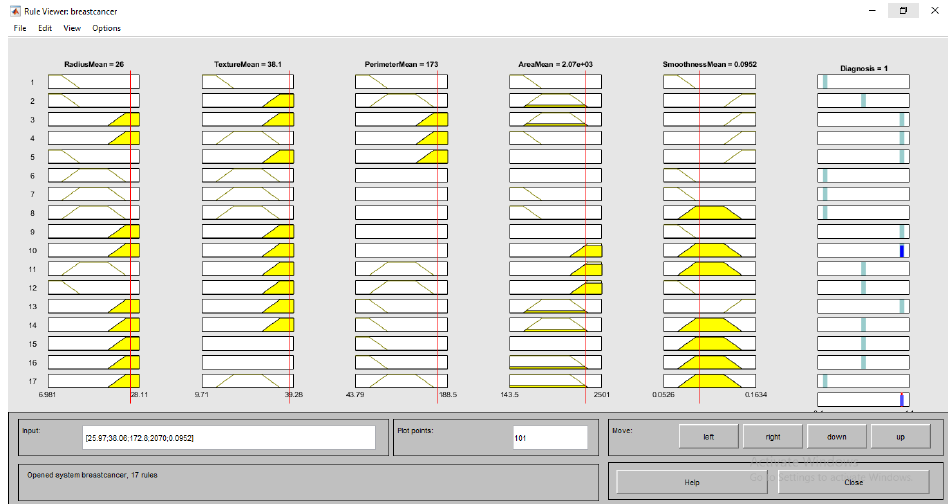
Figure 23. Diagnosis for severe cases.